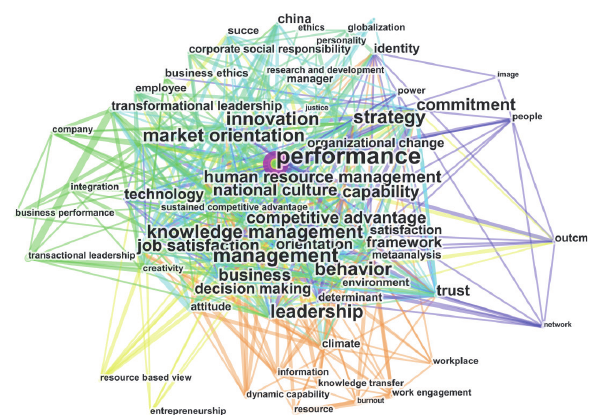
FIGURE 7: The map of keywords in co-citation relationship.